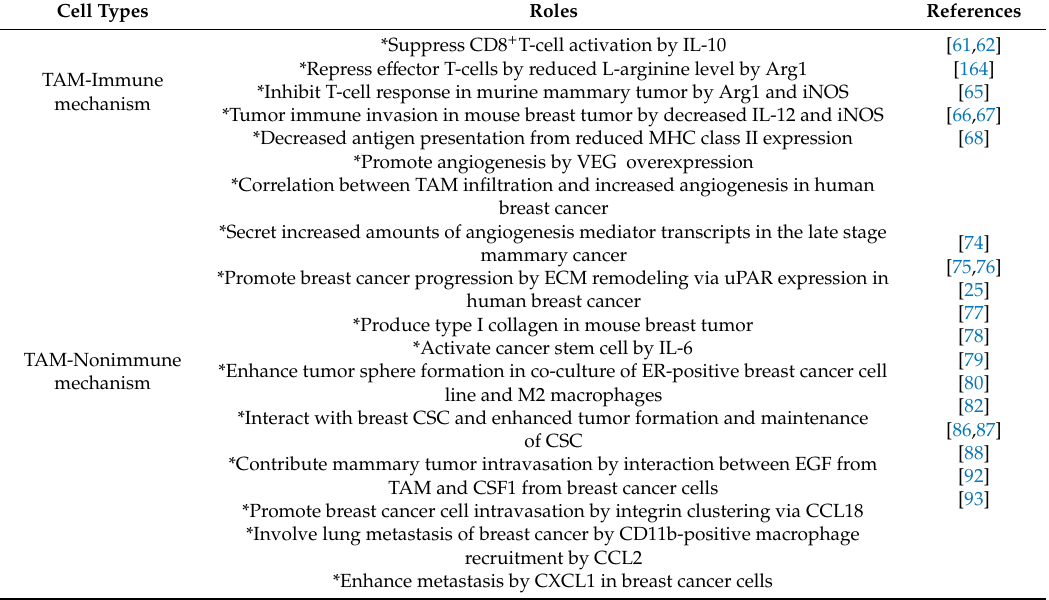
Table 1. Role of tumor-associated macrophages and myeloid-derived suppressor cells in breast